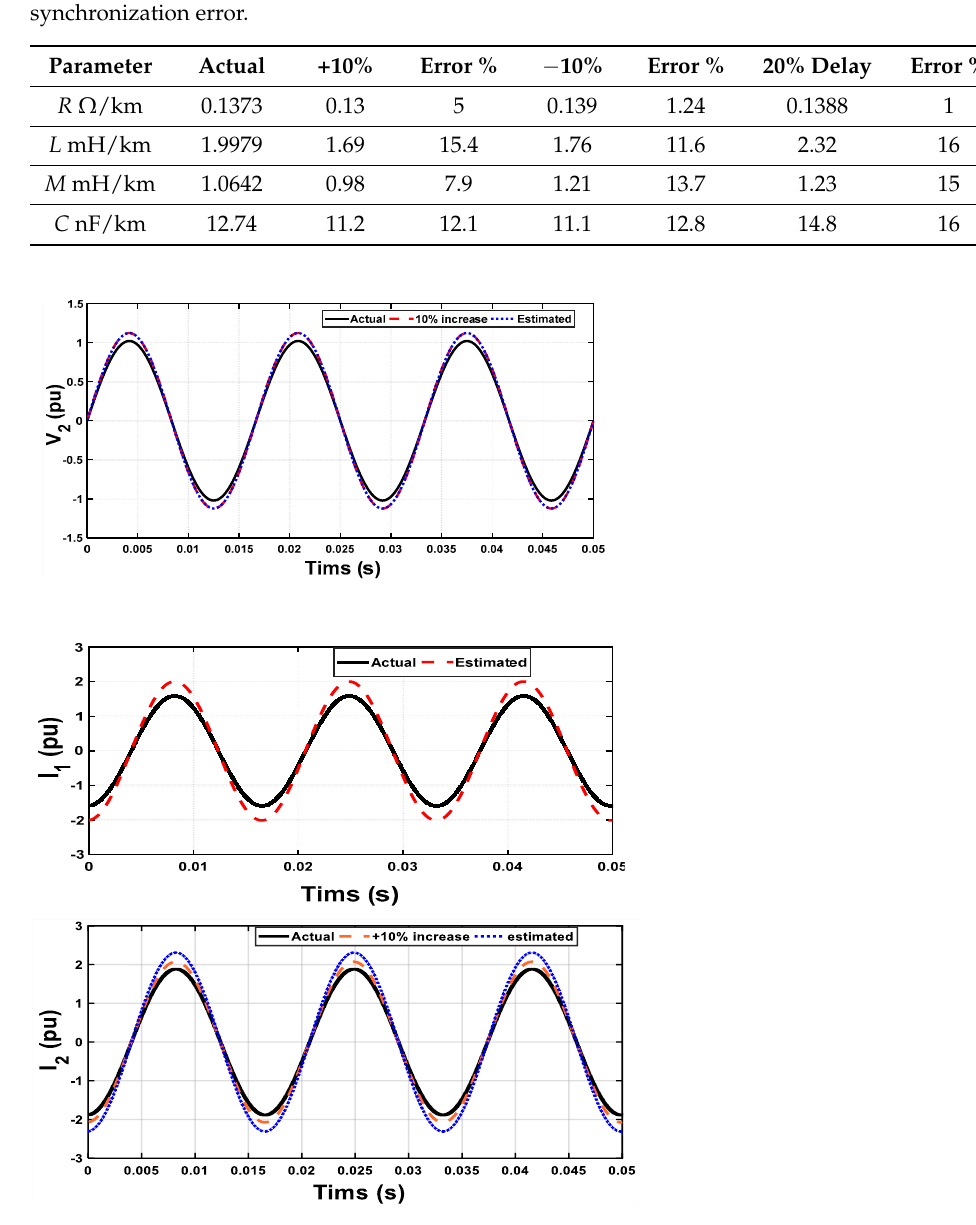
302 Figure 7. IEEE 14-bus system used in case study-3. 303